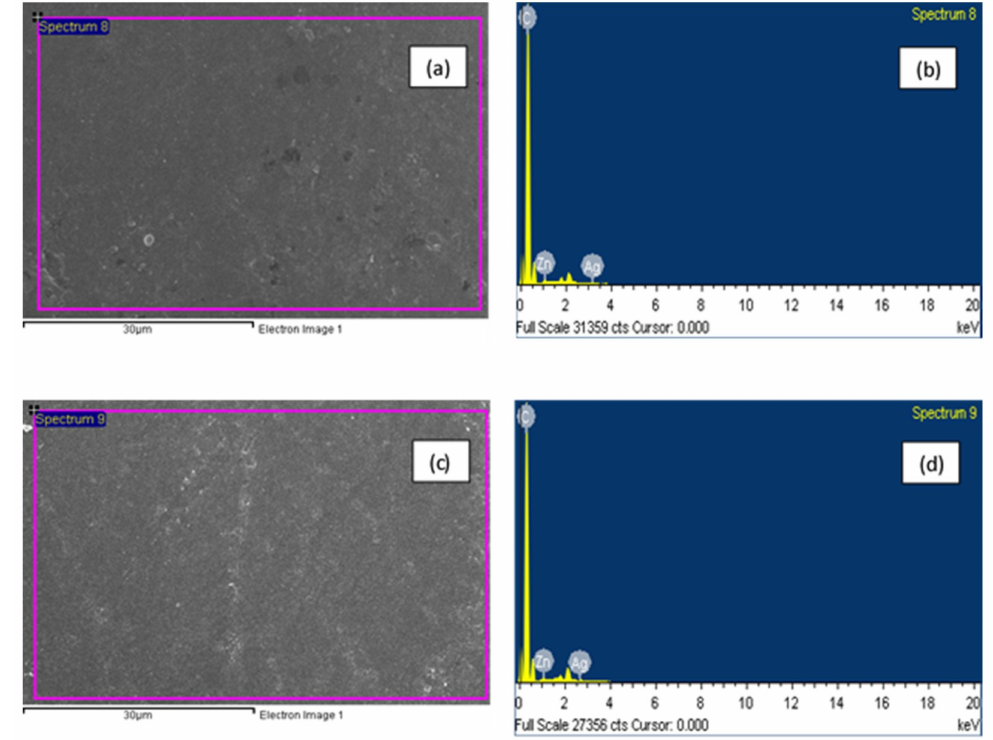
Figure 1. ( a , c ) Scanning electron microscope (SEM) images where energy dispersive X-ray spectroscopy (EDX) was performed, ( b , d ) EDX spectra obtained for F1and F2